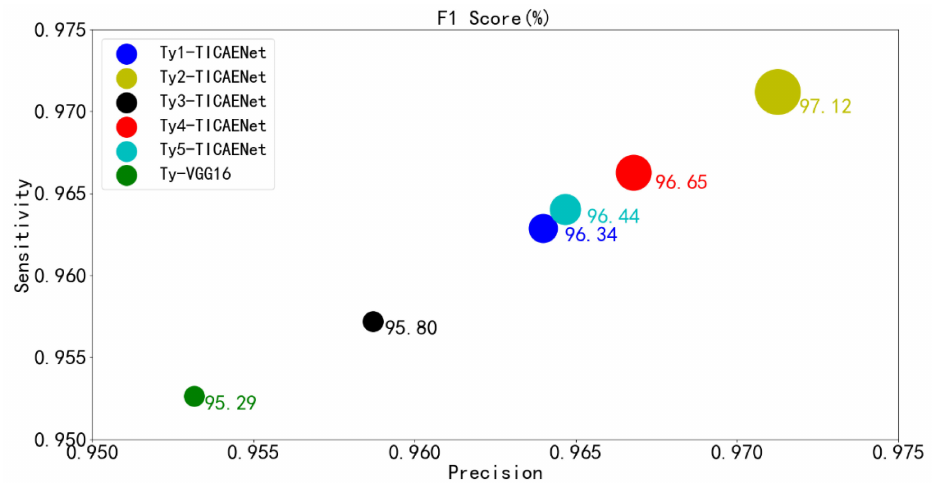
Figure 7. Different model F1 scores for the six TC categories.